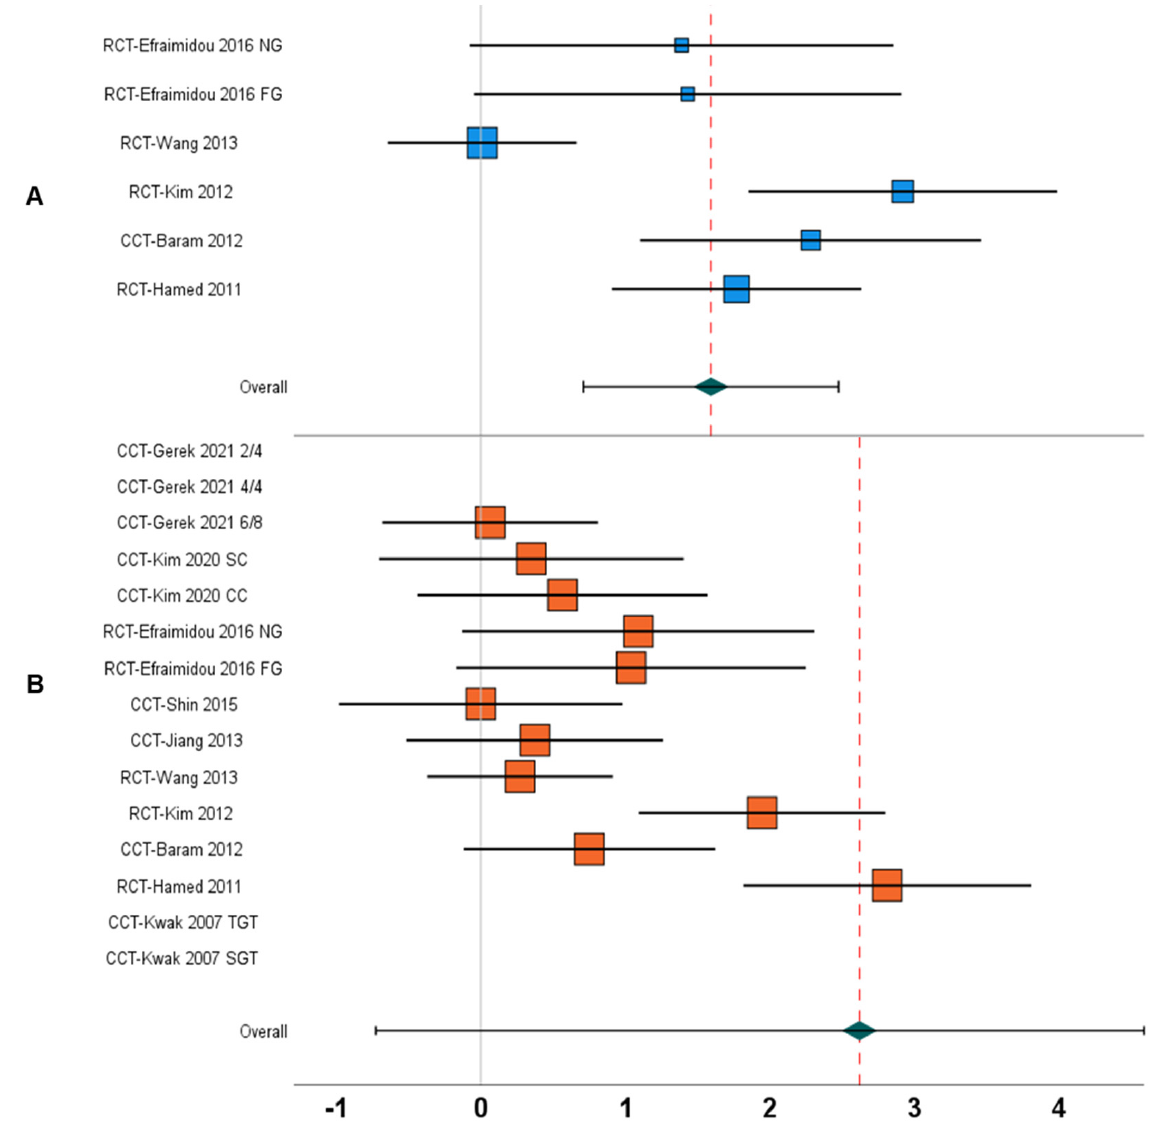
Figure 4. Forest plot illustrating the effect of AStim on gait speed in people with cerebral palsy. The forest plots incorporate individual weighted effect size (Hedge’s g), which is represented as boxes (blue: between-group, orange: within-group), whereas the 95% confidence intervals are represented with whiskers. At the bottom, the pooled weighted effect size and 95% CI are represented with a green diamond. ( A ) In this analysis, a positive overall effect size means an enhancement in gait speed for the AStim group, whereas a negative overall effect size indicates enhancements in gait speed for the control group. ( B ) A positive overall effect size means an enhancement in gait speed with AStim, whereas a negative overall effect size indicates reduction in gait speed with AStim (RCT: Randomized controlled trial, CCT: Controlled clinical trial, NG: Normal gait, FG: Fast gait, TGT: Therapist-guided training, SGT: Self-guided training).